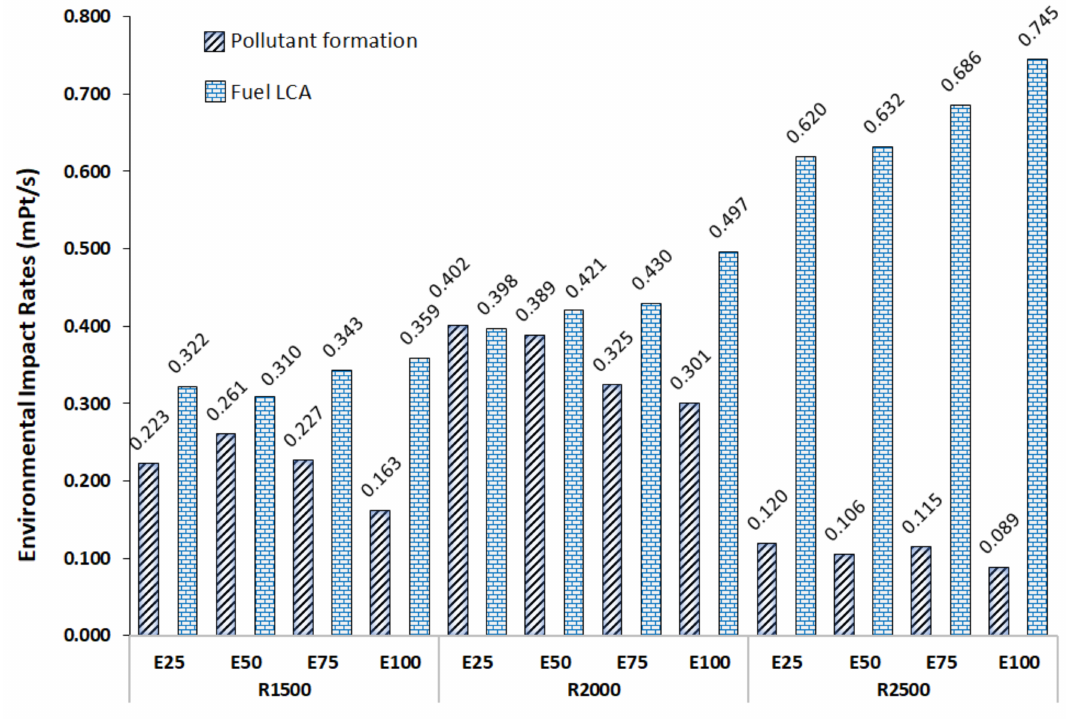
Figure 5. Variation in the environmental impact rates with ethanol